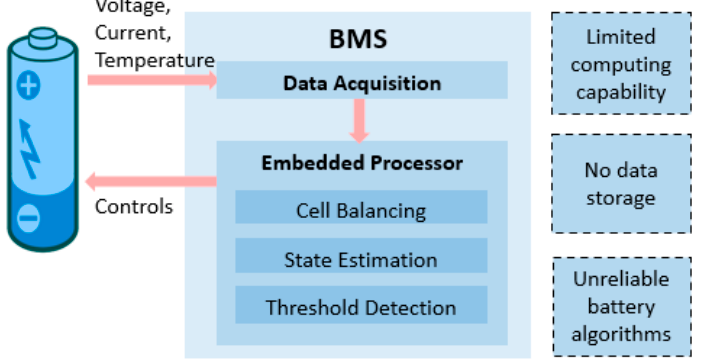
Figure 1. Current battery management system (BMS) design and functions.